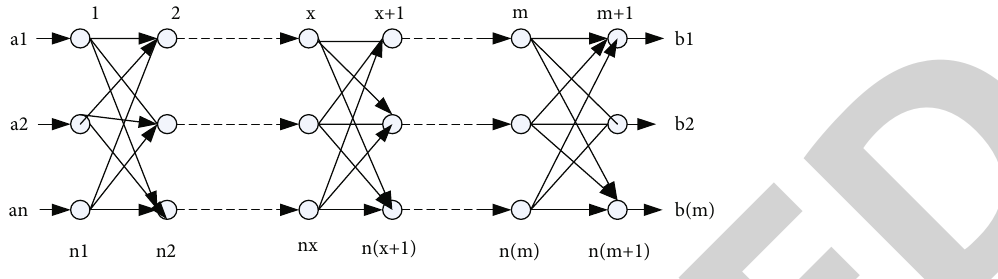
Figure 3: Schematic diagram of BP neural network